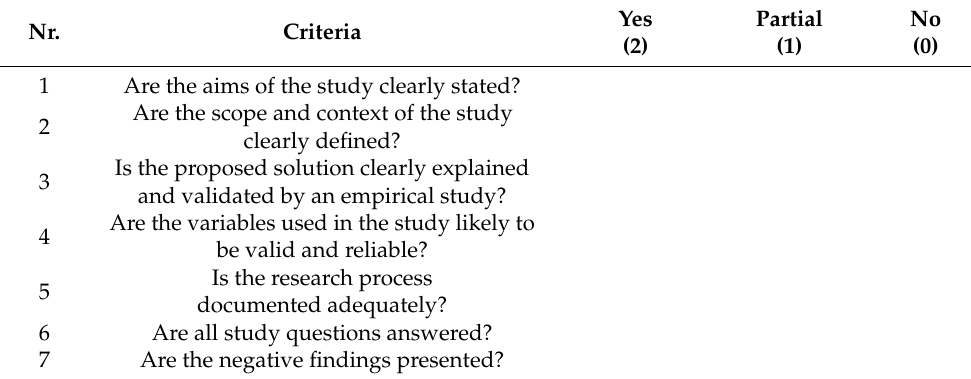
Table 3. Evaluation standards. The answer to each question scores the quality of the paper. Nr.